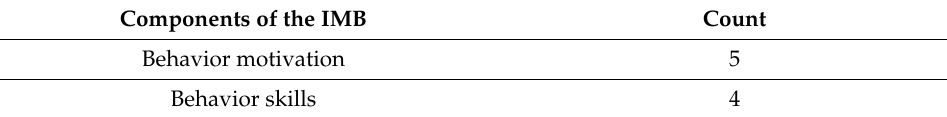
Table 8. Valid types of IMB